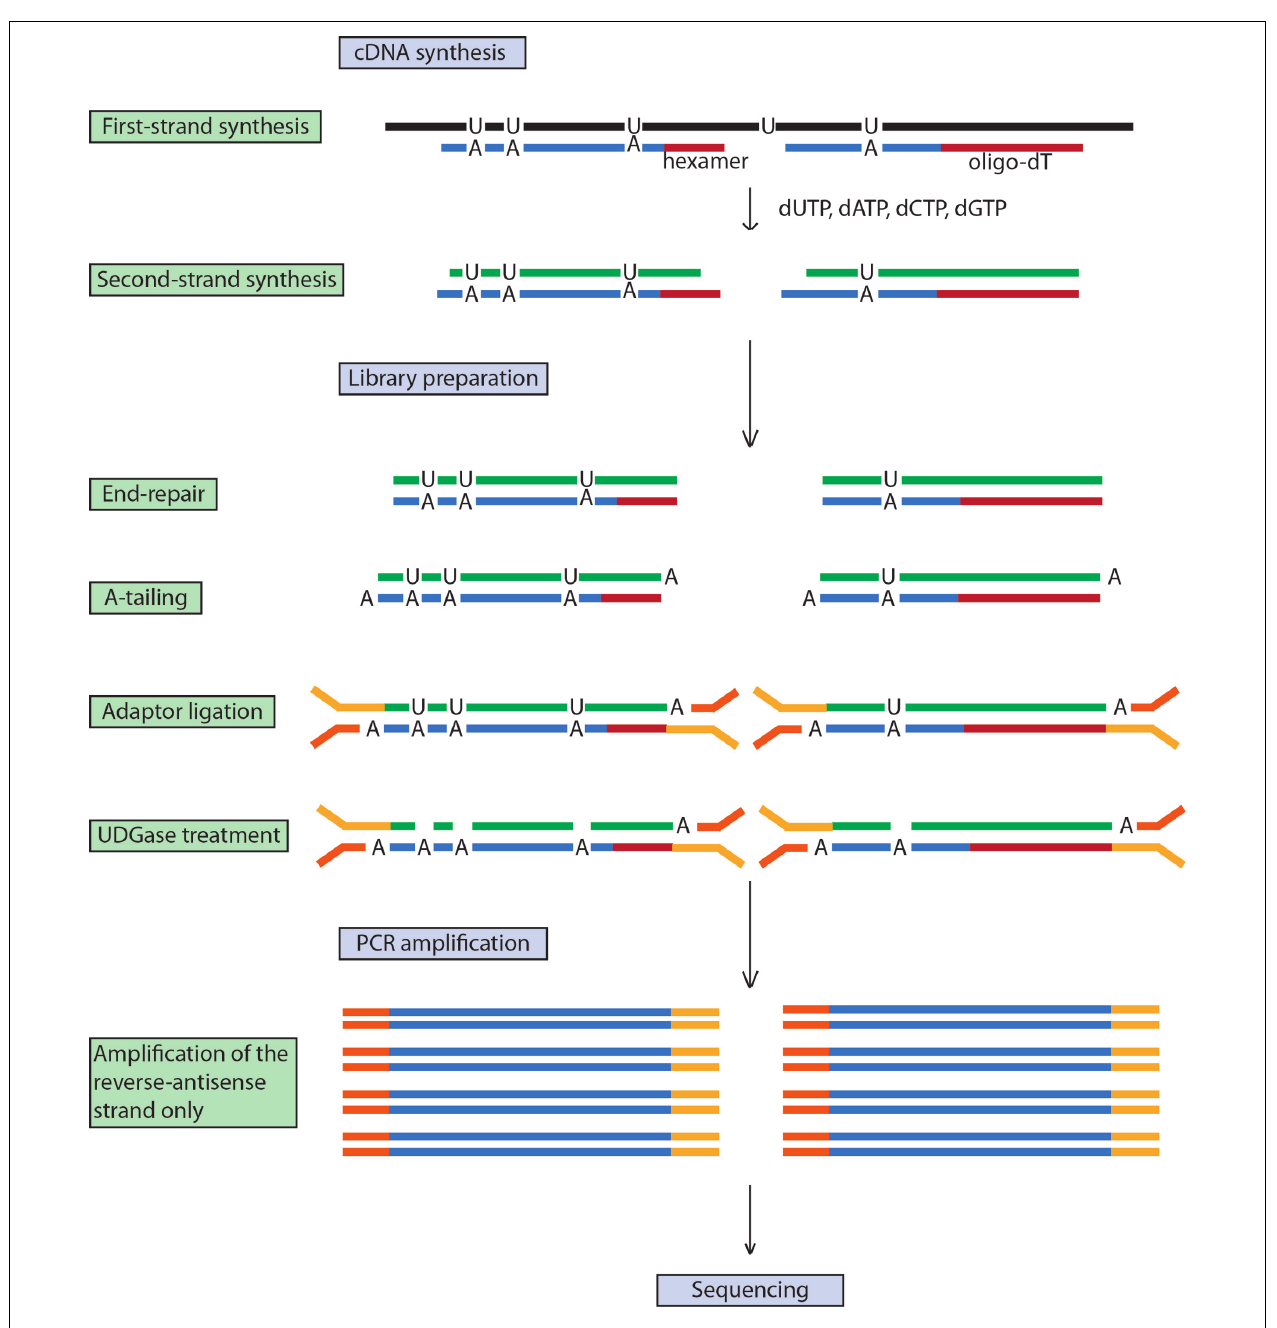
FIGURE 1 | dUTP-based strand-specific RNA-seq. Strand-specificity is achieved by the second-strand cDNA incorporating dUTPs instead of dTTPs. Digestion of dUTPs by uracil-DNA glycosylase (UGDase) prevents this strand from being PCR amplified, conferring single-strand specificity.